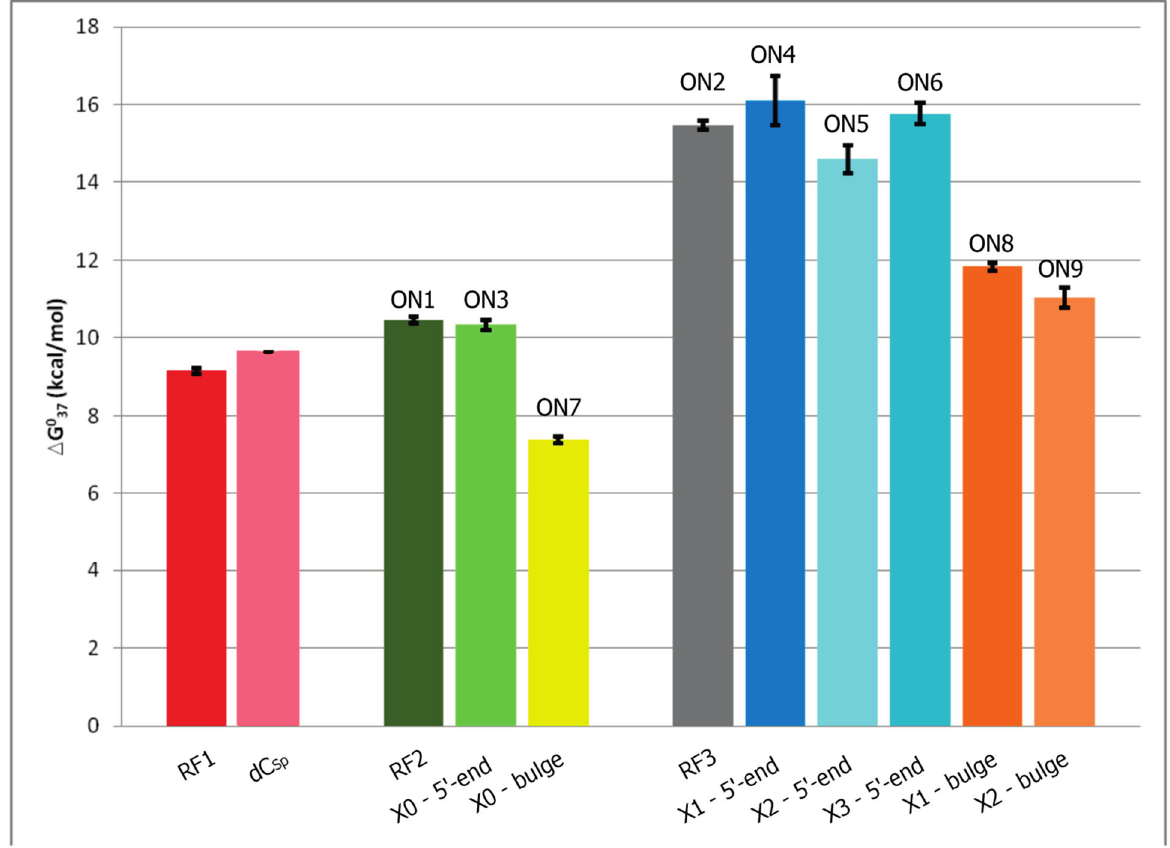
Figure 3. Changes in free energy ( Δ G) of polyamine modified duplexes: RF-RF3- reference duplexes, dCSp—spermine modified (dC Sp = 4- N -[4,9,13-triazatridecan-1-yl]-2 ′